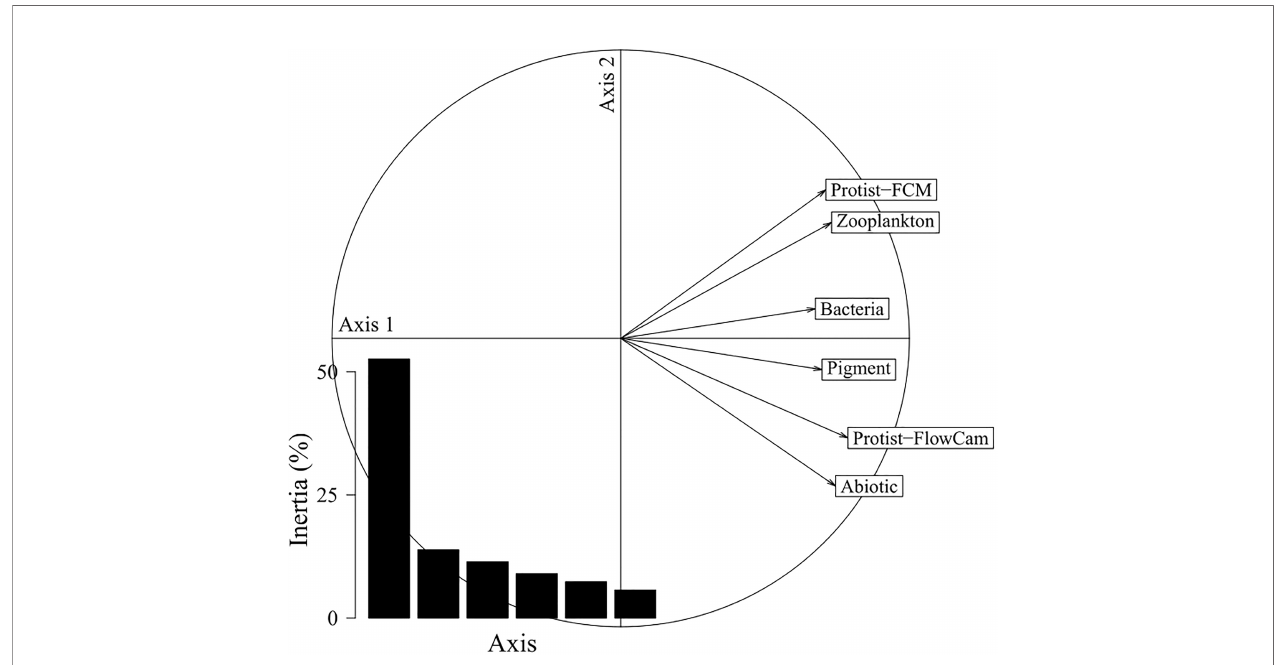
FIGURE 4 | STATIS interstructure correlation circle. Bar diagram, eigenvalues showing the uni-dimensional nature of the pattern, with ecosystem components being mainly correlated with the dominant fi rst axis (53%). Correlations between ecosystem components (RV-coef fi cients) are provided in Table 4